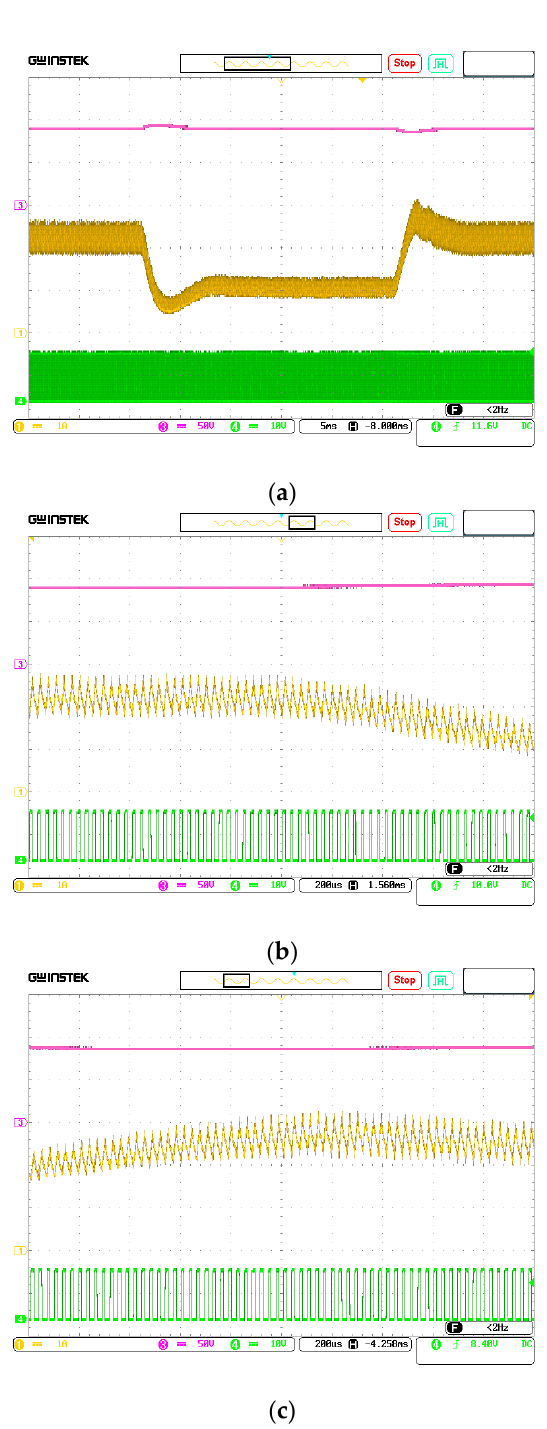
Figure 9. Response of v 0 (Top: 50 V/div, Pink), i L 1 (Middle: 1 A/div, Yellow) and v d (Bottom: 10 V/div, Green) with the step change of the resistive load R being 300 Ω – 600 Ω – 300 Ω . ( a ) Time: 5 ms/div; ( b ) Close-up view of response for the step changing of the resistive load R being 300 Ω – 600 Ω , Time: 200 µs/div; ( c ) Close-up view of response for the step changing of the load R being 600 Ω – 300 Ω , Time: 200 µs/div.